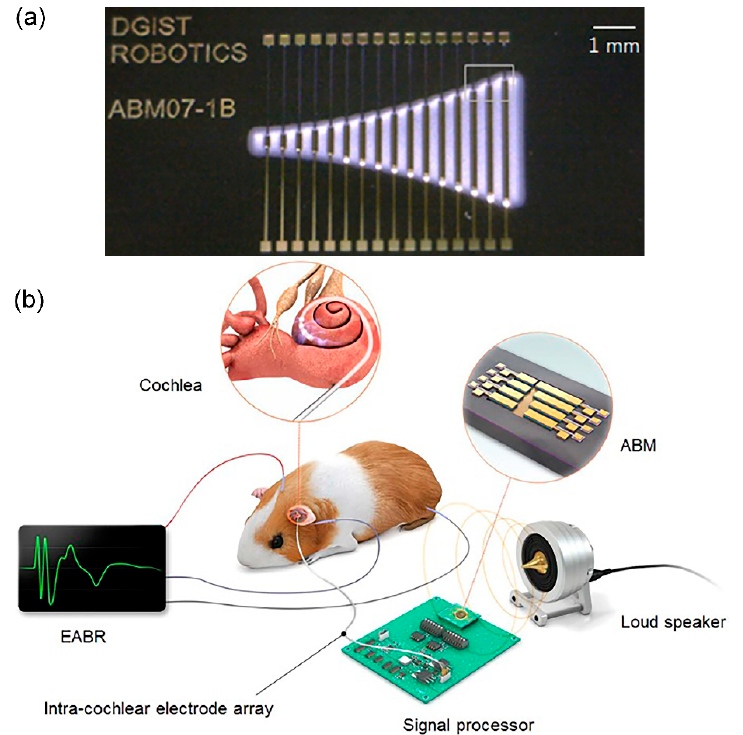
Figure 24. ( a ) The optical image of the fabricated Mo/AlN/Au beam array [86]. © IOP Publishing. Reproduced with permission. All rights reserved. ( b ) The schematic view of the experimental setup using Mo/AlN/Au cantilever array that generates piezoelectric voltage to the signal processor and intra-cochlear electrode array. The stimulating electrical signals onto the cochlea elicit eABR response from a deafened guinea pig [87].